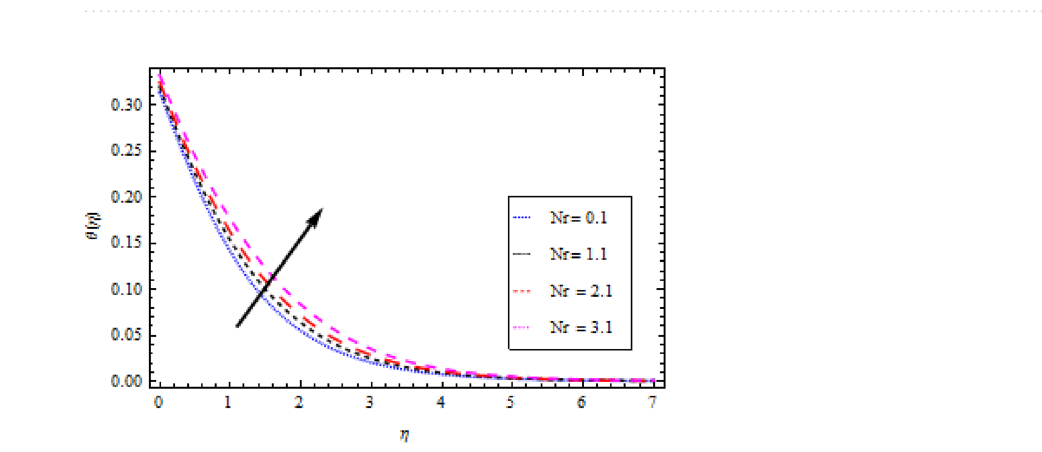
Figure 7. Temperature profile variation with respect to δ .